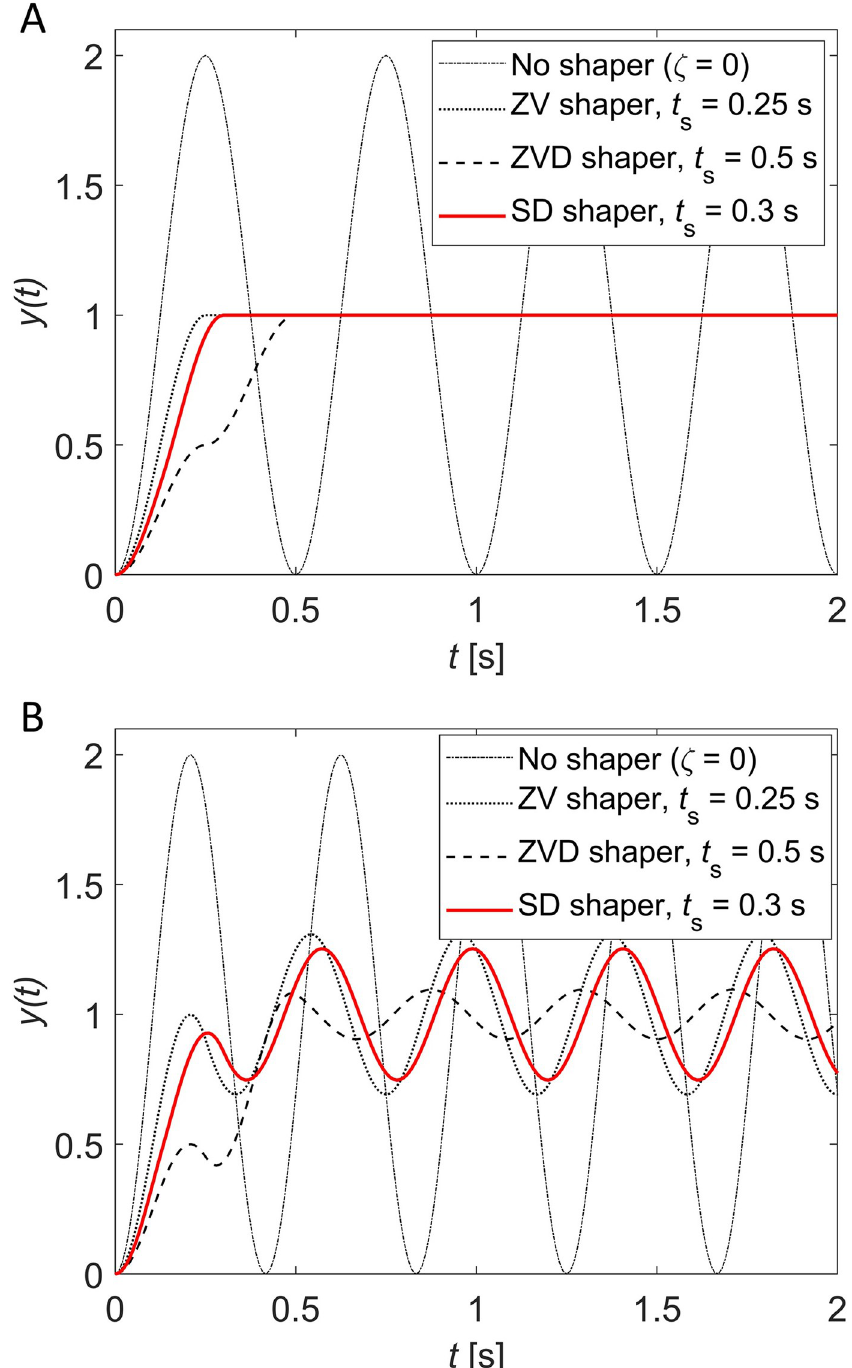
Fig 5. Unit-step responses when the SD shaper with t s = 0.3s is used for an undamped system ω 2 ^ ω ¼ 2 Hz . (A) No modeling error ( o n ^ o ¼ 2 Hz n